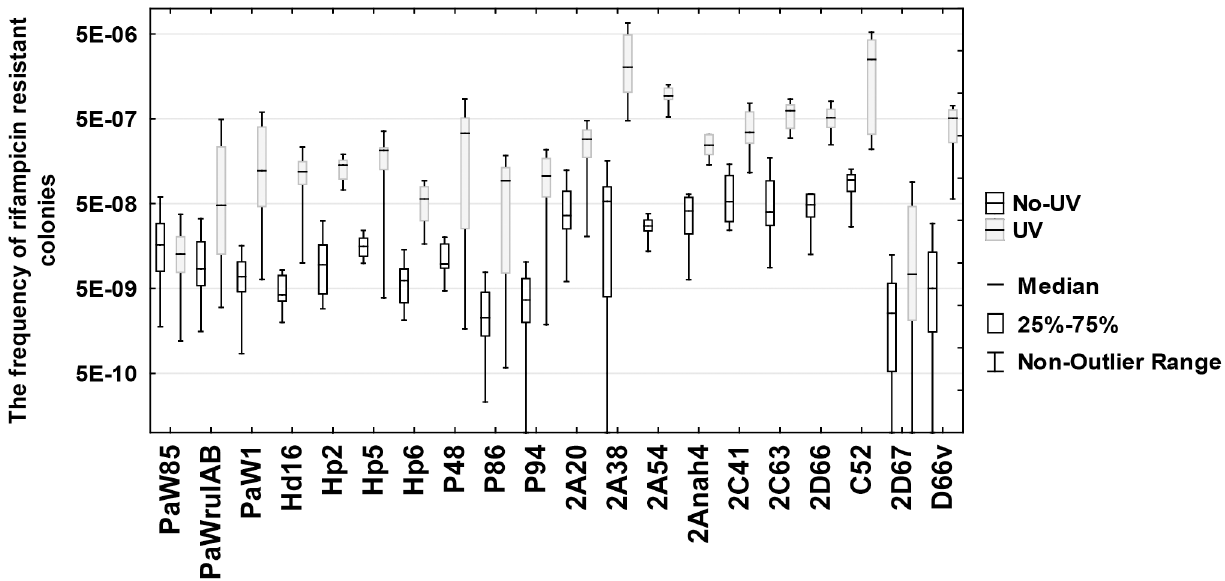
Fig 2. Comparison of spontaneous and UV-induced Rif r mutant frequencies. Presented are only the results with indigenousstrains exhibitingstatistically significantly increasedmutation frequency(p < 0.045)after the exposure to UV-C irradiationanalysedwith Mann-Whitney U test (S6